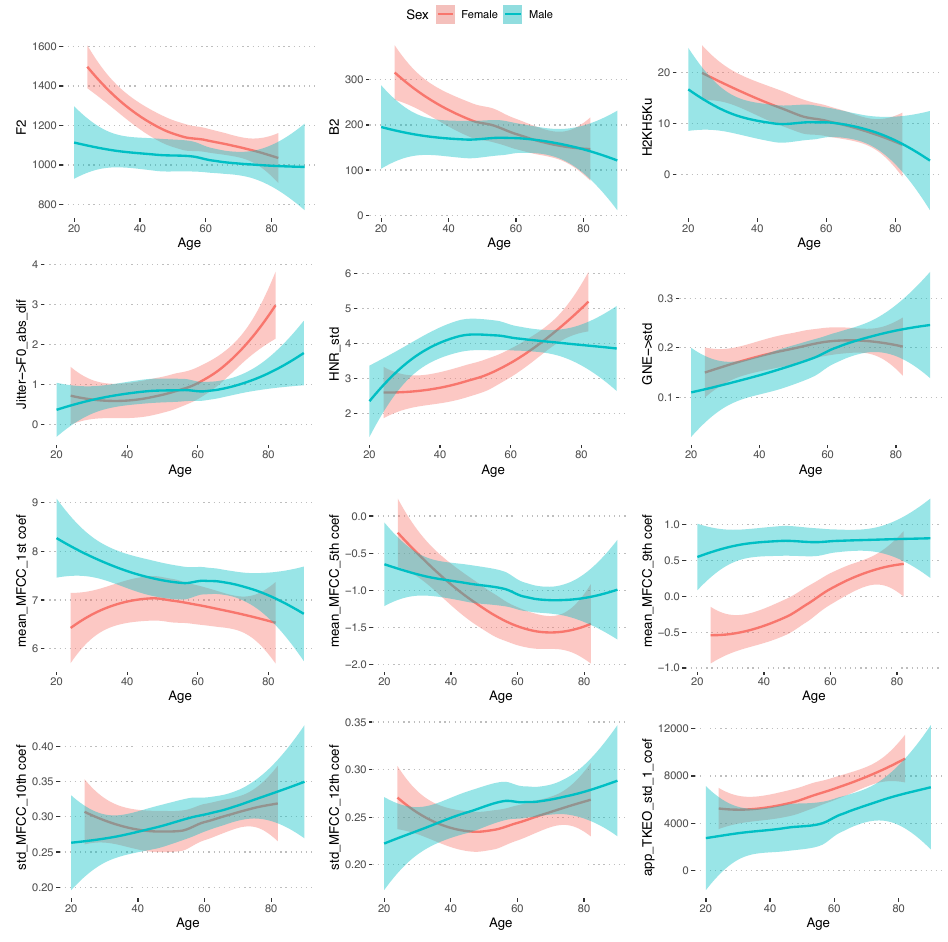
Figure 2. The sex-specific pattern of change with age for identified acoustic measures of a sustained [a]. The trend lines were computed as locally smoothed regression lines (LOESS) using a span of 0.75. For DDK sequences, 16 unique acoustic measures were identified to contribute to the prediction of a speaker’s age. The sex-specific differences in these measures between younger and older speakers are presented in Figure 4, along with the confidence region of the trend line. The DDK measures that were identified to contribute to the accurate prediction of sex-specific age of the speaker were DDK rate, variability in DDK rate (Rate (sd)), the average absolute difference between consecutive differences between consecutive syllable durations (DDP), the variability in syllable durations 5–12 compared to the average syllable duration of syllables 1–4 (relStab5–12), the percent of the syllable duration made up of the nucleus (%N), the average and standard deviation of the relative amplitude of the syllable onsets and nucleus (O/N Ampl., O/N Ampl. (sd)), the amplitude of syllables 13–20 compared to syllables 5–12 (AP), the average and standard deviation of the